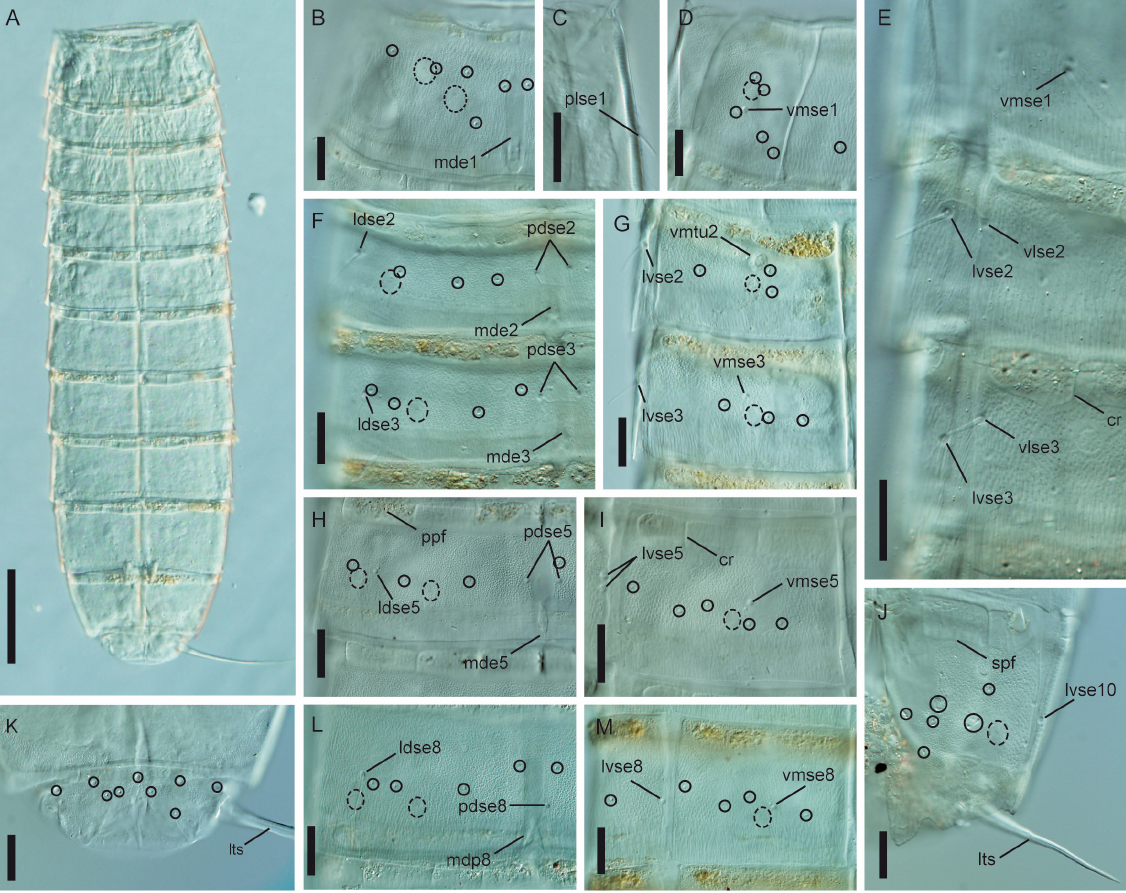
Fig. 3. Light micrographs of holotype, ♂ (NHMD-921475) (A–D, H–I, K–L), paratypes, ♂ (F–G, M) (F: NHMD-921479, G: NHMD-921489, M: NHMD-921484), and paratype, ♀ (E, J) (NHMD-921485), showing trunk overviews and details of cuticular trunk characters of adult Setaphyes algarvensis sp. nov. A . Dorsal overview. B . Dorsal view of left half of segment 1. C . Detail of paralateral seta of segment 1. D . Ventral view of right half of segment 1. E . Ventral view of right half of segments 1–3. F . Dorsal view of left half of segments 2–3. G . Ventral view of right half of segments 2–3. H . Dorsal view of left half of segment 5. I . Ventral view of right half of segment 5. J . Ventral view of left half of segment 10. K . Dorsal view of segment 11. L . Dorsal view of left half of segment 8. M . Ventral view of right half of segment 8. Abbreviations: cr = cuticular ridge; ldse = laterodorsal seta; lts = lateral terminal spine; lvse = lateroventral seta; mde = middorsal elevation; mdp = middorsal process; pdse = paradorsal seta; plse = paralateral seta; ppf = primary pectinate fringe; spf = secondary pectinate fringe; vlse = ventrolateral seta; vmse = ventromedial seta; vmtu = ventromedial tube; numbers after abbreviations indicate corresponding segment; sensory spots are marked as dashed circles and glandular cell outlets as continuous circles. Scale bars: A = 100 µm; B–M = 20 µm.